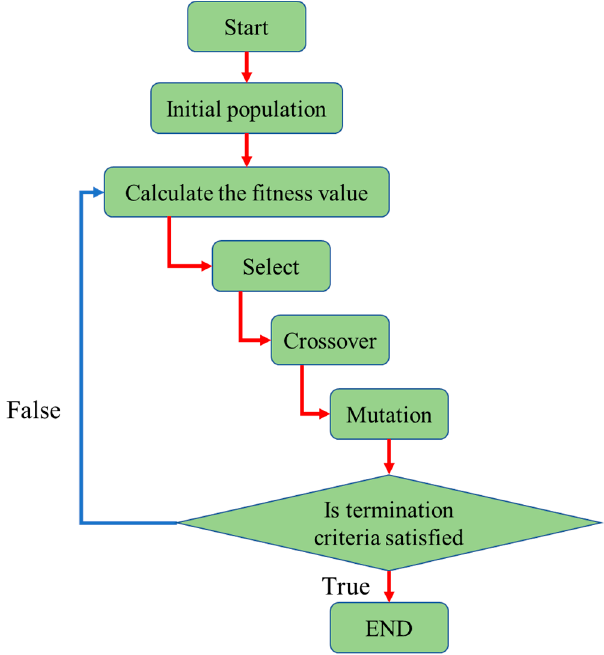
Figure 9. Conceptual representation of the GA algorithm.